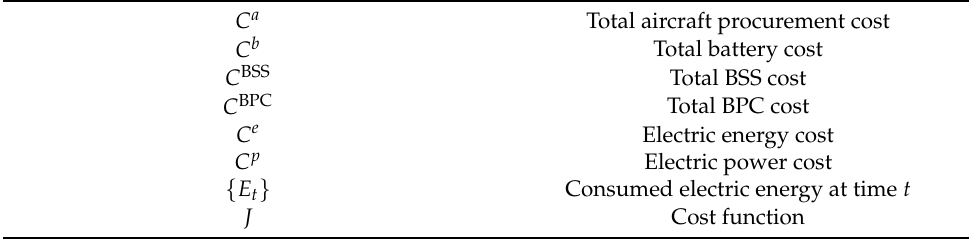
Table 4. ARES output